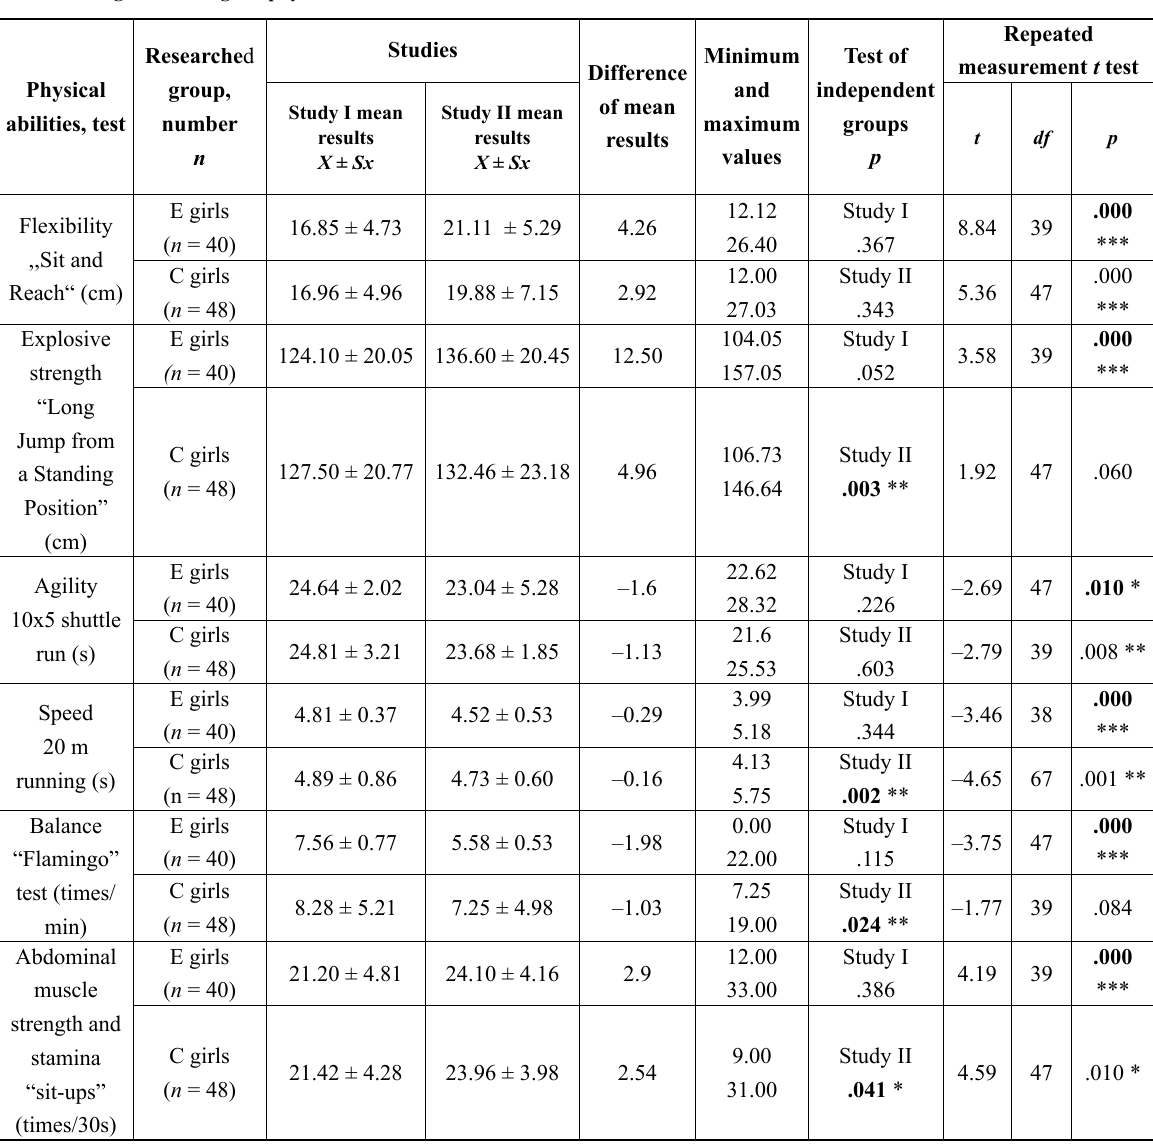
Table 1. Change results of girls’ physical